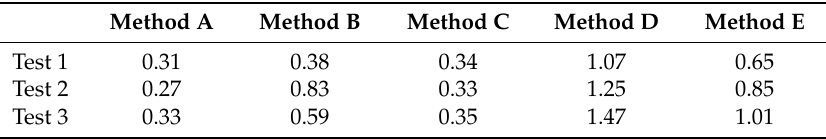
Table 2. Root mean square errors of external acceleration (unit: m/s 2 ).